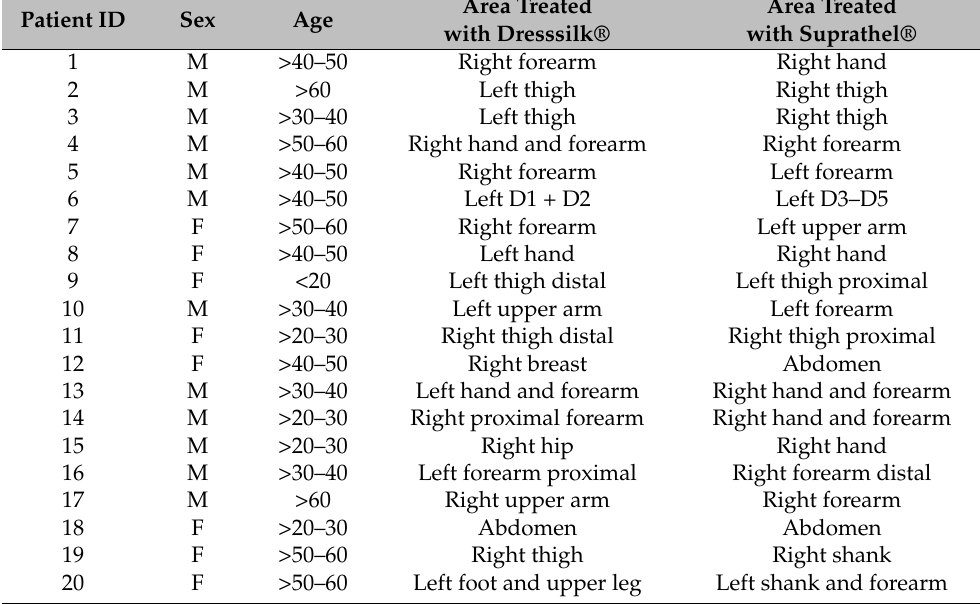
Table 1. Patient characteristics (age, sex and location of treated